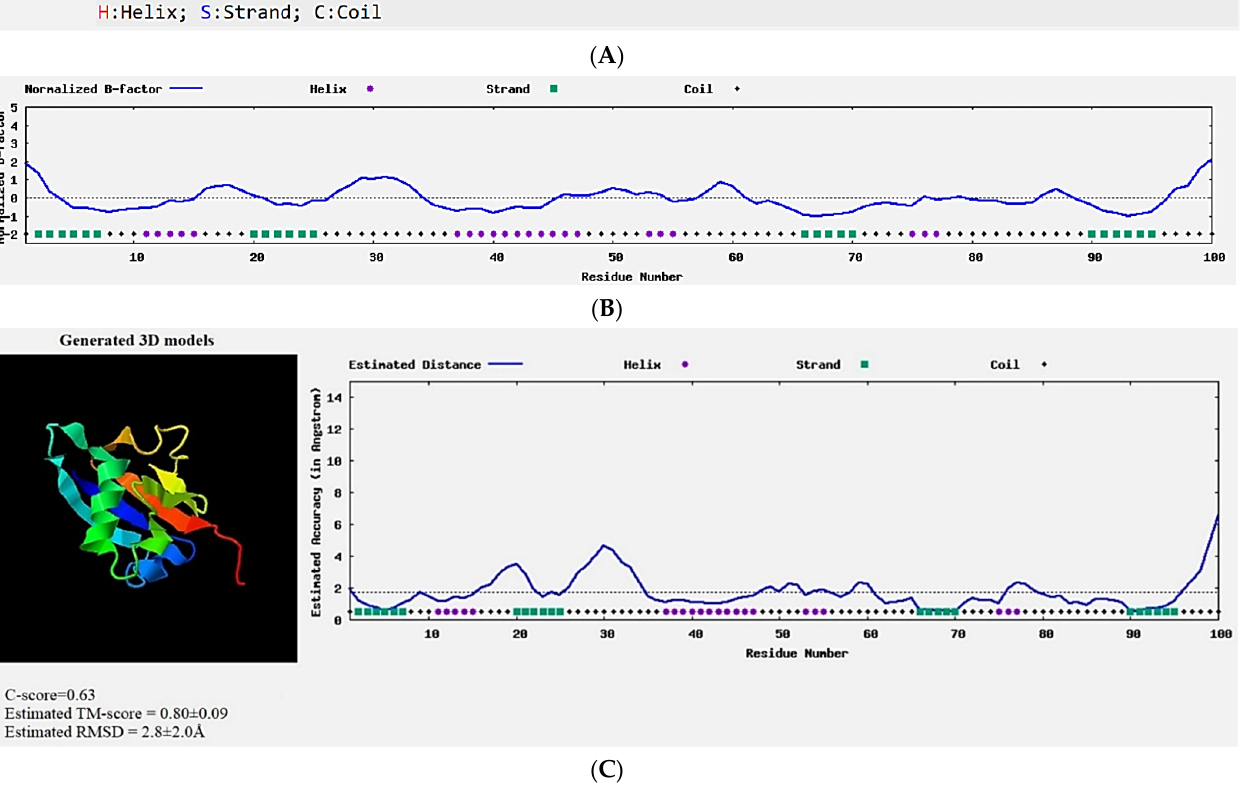
Figure 5. ( A ) Putative OsSUMO7 protein prediction of secondary structure by PSSpred. ( B ) The predicted normalized B-factor of OsSUMO7 by ResQ. ( C ) The predicted 3D model, as well as the estimated global and local accuracy of the OsSUMO7, calculated by the I-TASSER server. estimated global and local accuracy of the OsSUMO7, calculated by the I-TASSER